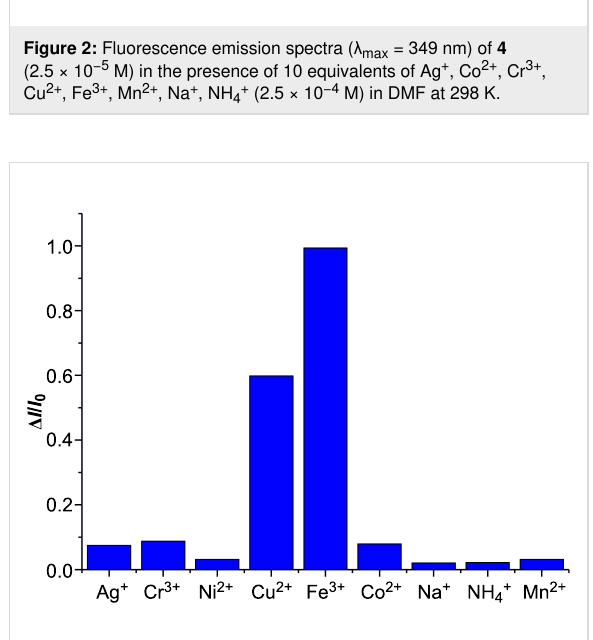
Figure 3: Column diagram of fluorescence quenching efficiency of 4 (2.5 × 10 − 5 M) in the presence of 10 equivalents of Ag + , Cr 3+ , Ni 2+ , Cu 2+ , Fe 3+ , Co 2+ , Na + , NH 4 + and Mn 2+ (2.5 × 10 − 4 M) in DMF at 298 K (nitrate salts were used as cation source).